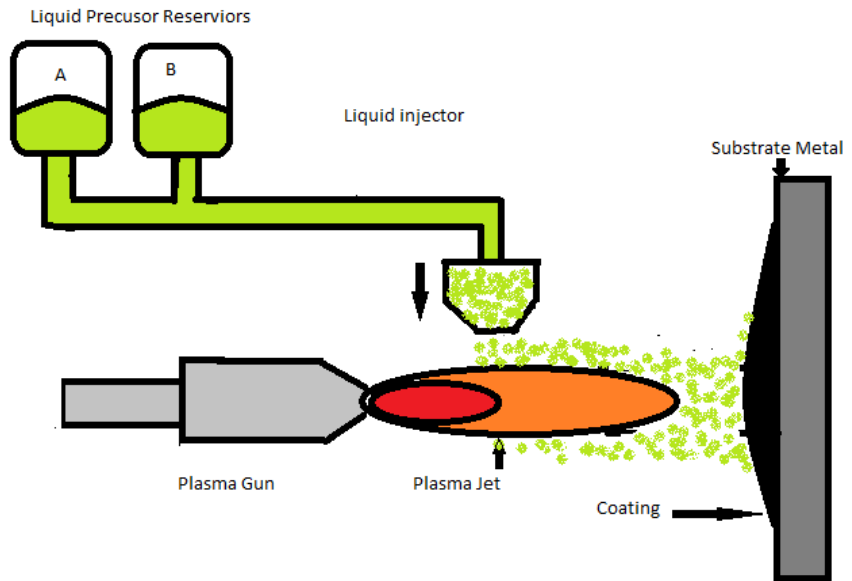
Figure 14. Schematic view of a Solution Precursor Plasma Spray system with radial injection.